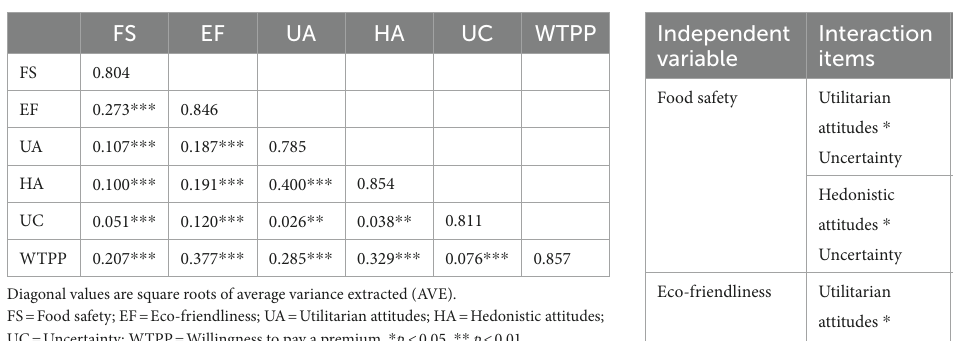
TABLE 4 Pearson’s correlations.